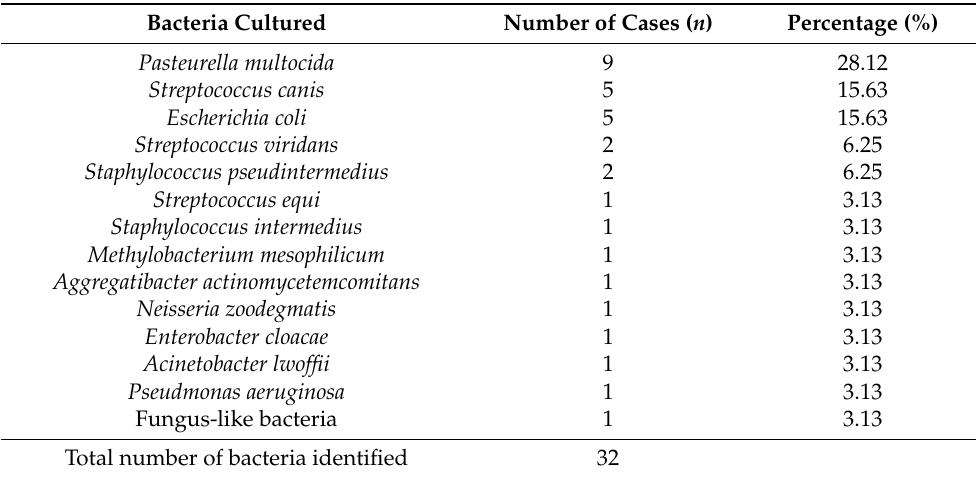
Table 7. Bacteria cultured from 28 cases of cats with pyothorax.